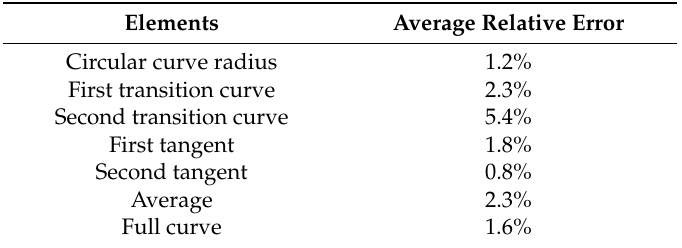
Table 5. Average relative error of three units of the track